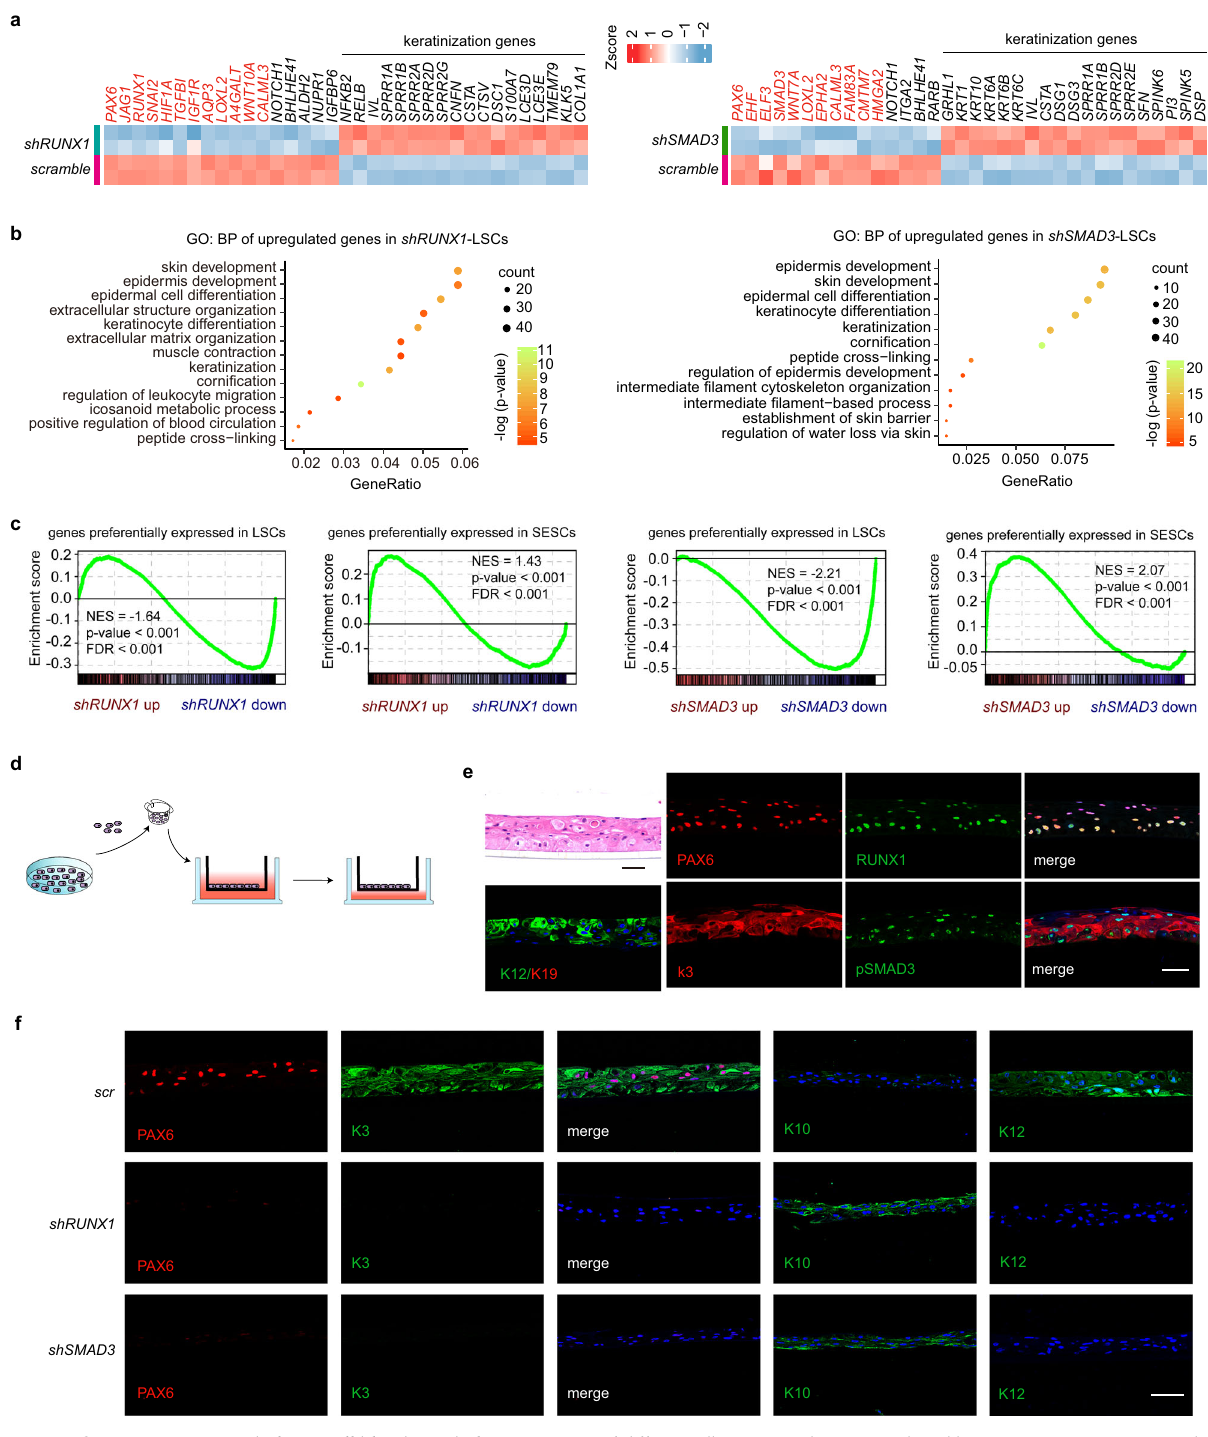
Fig. 3 Loss of RUNX1 or SMAD3 induces cell identity switch. a Heatmaps of differentially expressed genes produced by RUNX1 or SMAD3 KD. Red mark represents SE-assigned genes. b GO BP analysis for the upregulated genes in RUNX1 -depleted and SMAD3 -depleted LSCs (pvalueCutoff = 0.01 and qvalueCutoff = 0.05). c GSEA for genes that (i) are expressed at higher levels in LSCs than in SESCs and (ii) are more highly expressed in SESCs than in LSCs. NES: normalized enrichment score. d Schema representation of the air-lifting culture system. LSCs were seeded in the transwell inserts and incubated in medium until they were con fl uent. Then, the medium in the upper chamber was removed to induce differentiation into a strati fi ed epithelium sheet. e Hematoxylin and eosin (H&E) and immuno fl uorescence staining of the indicated genes in the differentiated corneal epithelium sheet after air- lifting induction. Scale bars, 50 μ m. f Immuno fl uorescence staining of the indicated genes in the differentiated corneal epithelium sheets treated with the indicated shRNAs. Scale bar, 50 μ